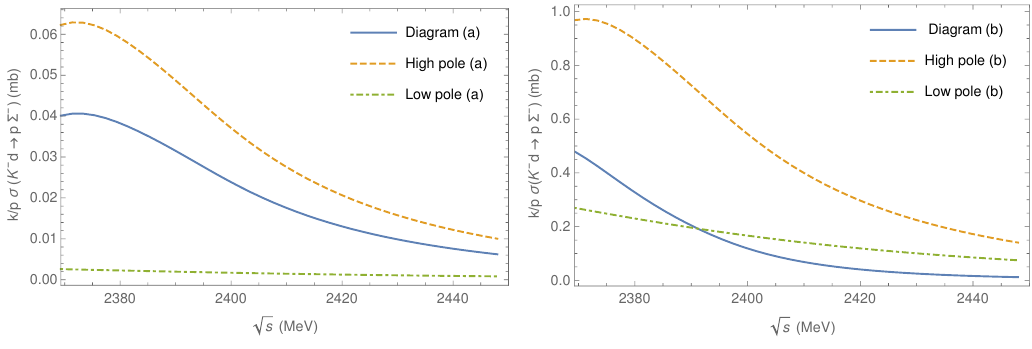
Figure 3. Contributions of the high and low mass poles to the diagrams (a) and (b) in k